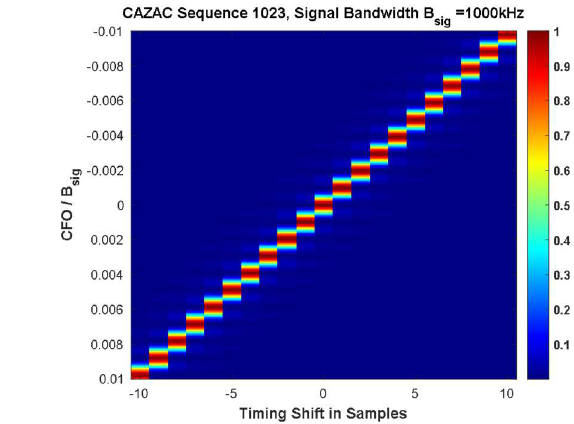
Figure 7. Cross-correlation performance of bipolar M-sequences used for time–frequency synchronization.